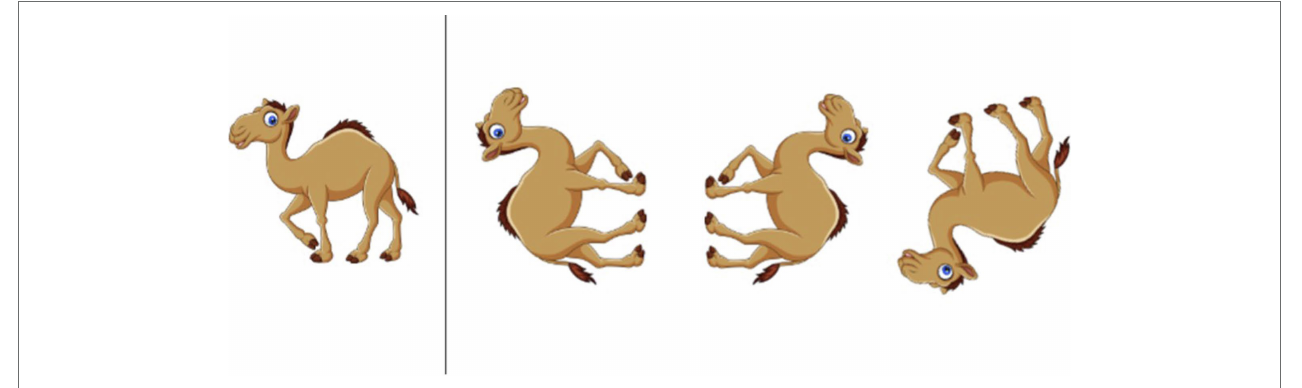
FIGURE 1 | Example trial from the mental rotation